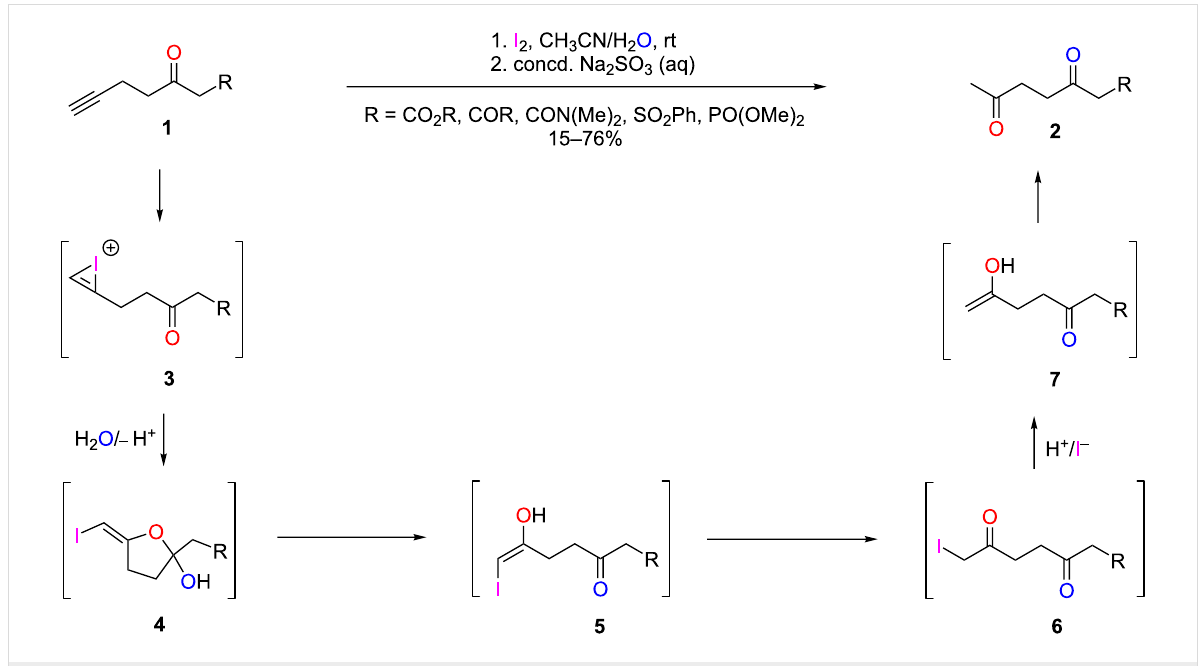
Scheme 1: Proposed mechanism for the iodine-mediated hydration of terminal alkynes 1